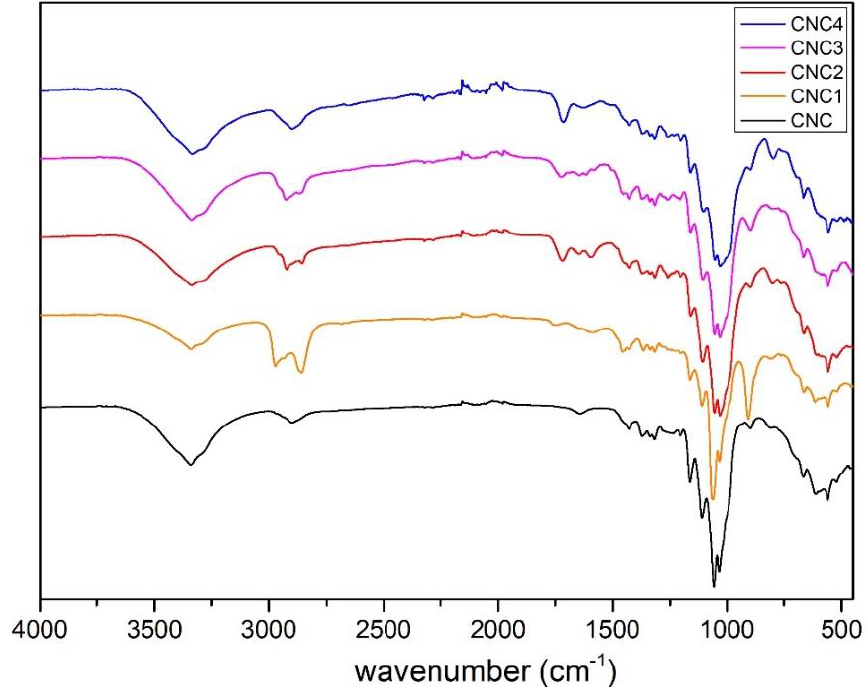
Figure 1. FTIR spectra (4000–500 cm − 1 ) of the neat CNC and grafted CNCs.